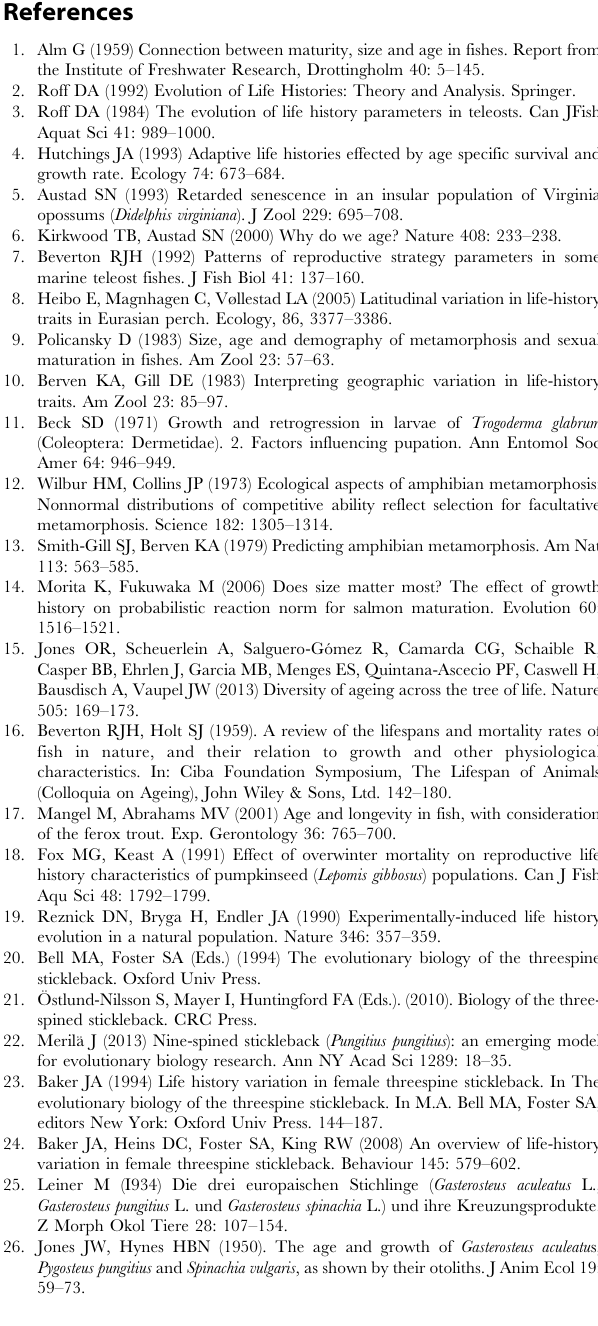
Table S1 Information on physical and biological char- acteristic of the study